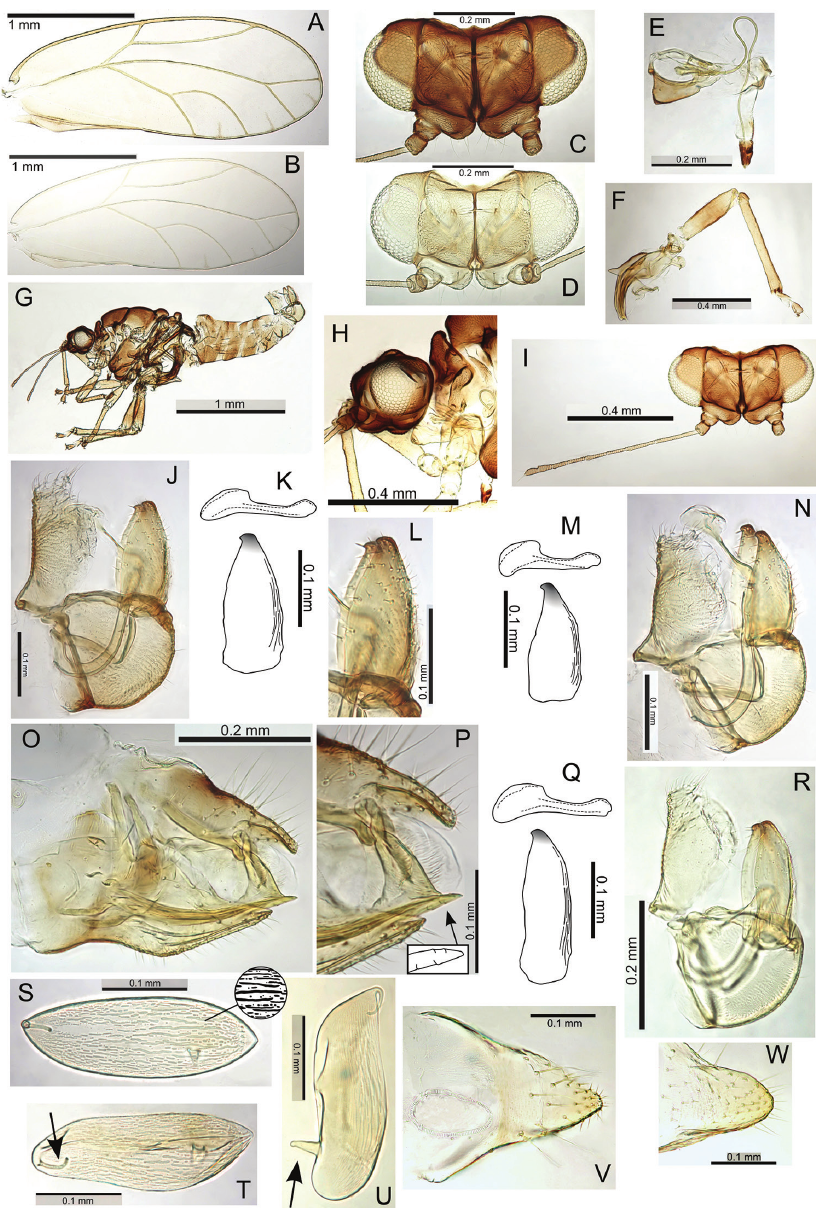
Figure 17. Pariaconus dorsostriatus sp. n. A, B fore wing: A (Kohala, Hawaii) B (Olaa, Hawaii) C, D head: C (Kohala, Hawaii) D (Olaa, Hawaii) E proboscis F hind leg G male H head I head and antennae J, K, L form kohalensis variation 1 (Kohala, Hawaii): J male terminalia K aedeagus and paramere L paramere M, N form kohalensis variation 2 (Kohala, Hawaii): M aedeagus and paramere N male termi- nalia O female terminalia P ovipositor (serrations indicated) Q, R form communis (Olaa, Hawaii): Q ae- deagus and paramere R male terminalia S, T, U eggs (pedicel, tail, and striations indicated): S, T (Kohala, Hawaii) U (Olaa, Hawaii) V female proctiger (dorsal view) W female subgenital plate (ventral